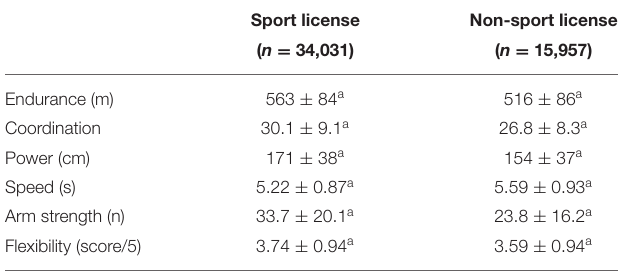
TABLE 3 | Performances during the tests of physical fitness according to sport